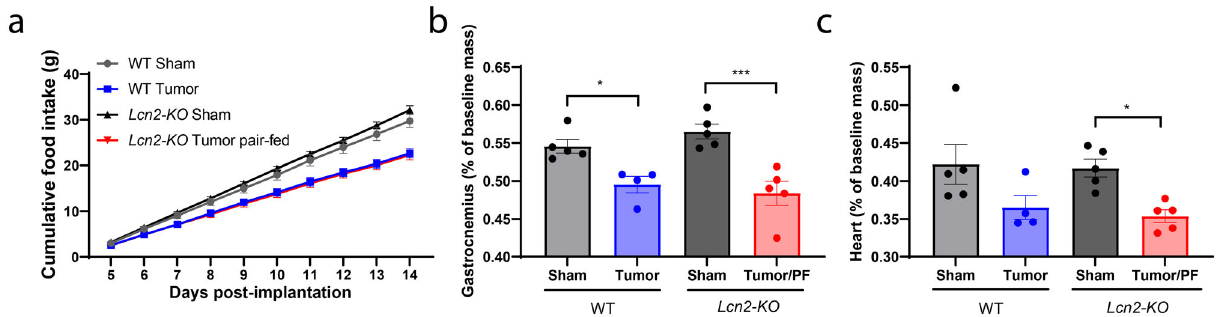
Fig. 6 Pair feeding abolishes muscle gain in Lcn2-KO mice during cachexia. a Cumulative food intake after the initiation of cachexia symptoms. N = 5 per group. b Terminal gastrocnemius and c cardiac tissue mass normalized to baseline mass. N = 5 per group for WT sham, Lcn2-KO sham, and Lcn2-KO tumor groups; N = 4 for the WT tumor group. Cumulative food intake data were analyzed by a repeated-measures Two-way ANOVA followed by Bonferroni ’ s post hoc test. Data presented in b , c were analyzed by a Two-way ANOVA followed by Bonferroni ’ s post hoc test. * p ≤ 0.05, ** p ≤ 0.01, *** p ≤ 0.001, and **** p ≤ 0.0001. PF pair-fed. All data are expressed as mean ± SEM. Gray = WT sham operation control; black = Lcn2-KO sham operation control; blue